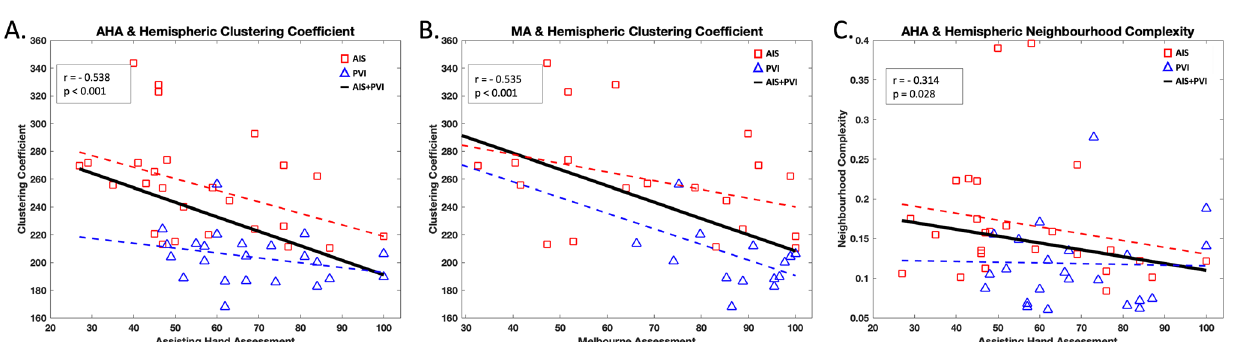
Figure 5. Hemispheric graph theory metrics and clinical motor function. ( A ) Hemispheric clustering coefficient was inversely related to AHA ( A ) and MA ( B ). The average neighbourhood complexity across the hemisphere was also inversely related to AHA ( C ). AHA assisting hand assessment, MA Melbourne assessment, AIS arterial ischemic stroke, PVI periventricular venous motor function assessments (all p > 0.57). There were no significant associations between motor network metrics and the BBT (minimum p = 0.21). Hemispheric network metrics between groups. Betweenness centrality was higher in both AIS (80.3 ± 7.6, p < 0.001, d = 4.27) and PVI (80.2 ± 5.3, p < 0.001, d = 5.58) compared to TDC (54.9 ± 3.6; F